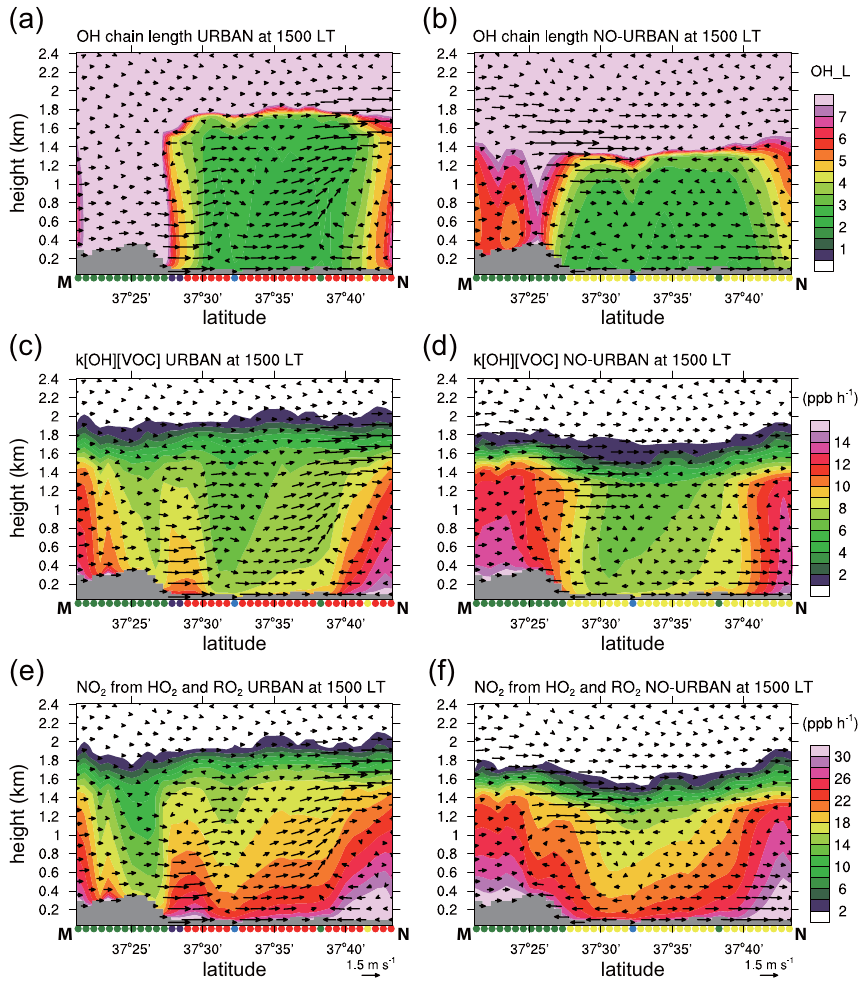
Fig. 11. Vertical cross sections of (a) OH chain length, (c) rate of reactions between OH and VOCs, (e) NO 2 production from the reactions between NO and peroxy radicals (HO 2 and RO 2 ) , and wind along the line M–N in Fig. 1d at 15:00 LT in the URBAN simulation. (b) , (d) , and (f) are the same as (a) , (c) , and (e) , respectively, but for the NO-URBAN simulation. The color of circles on the x-axis corresponds to the color of the LULC in Fig.